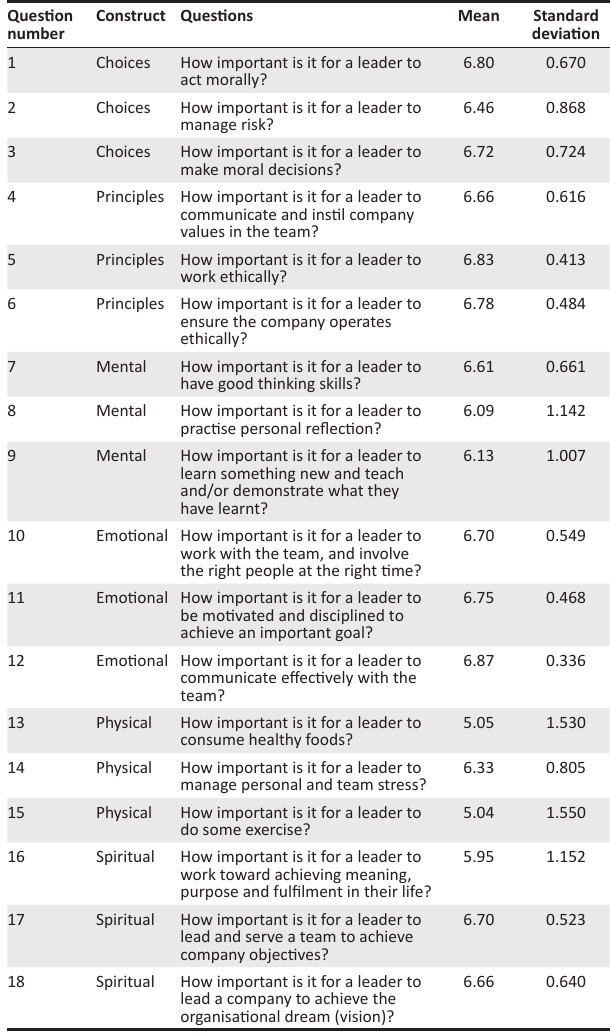
TABLE 3 : Online survey questionnaire results. Question Construct Questions number